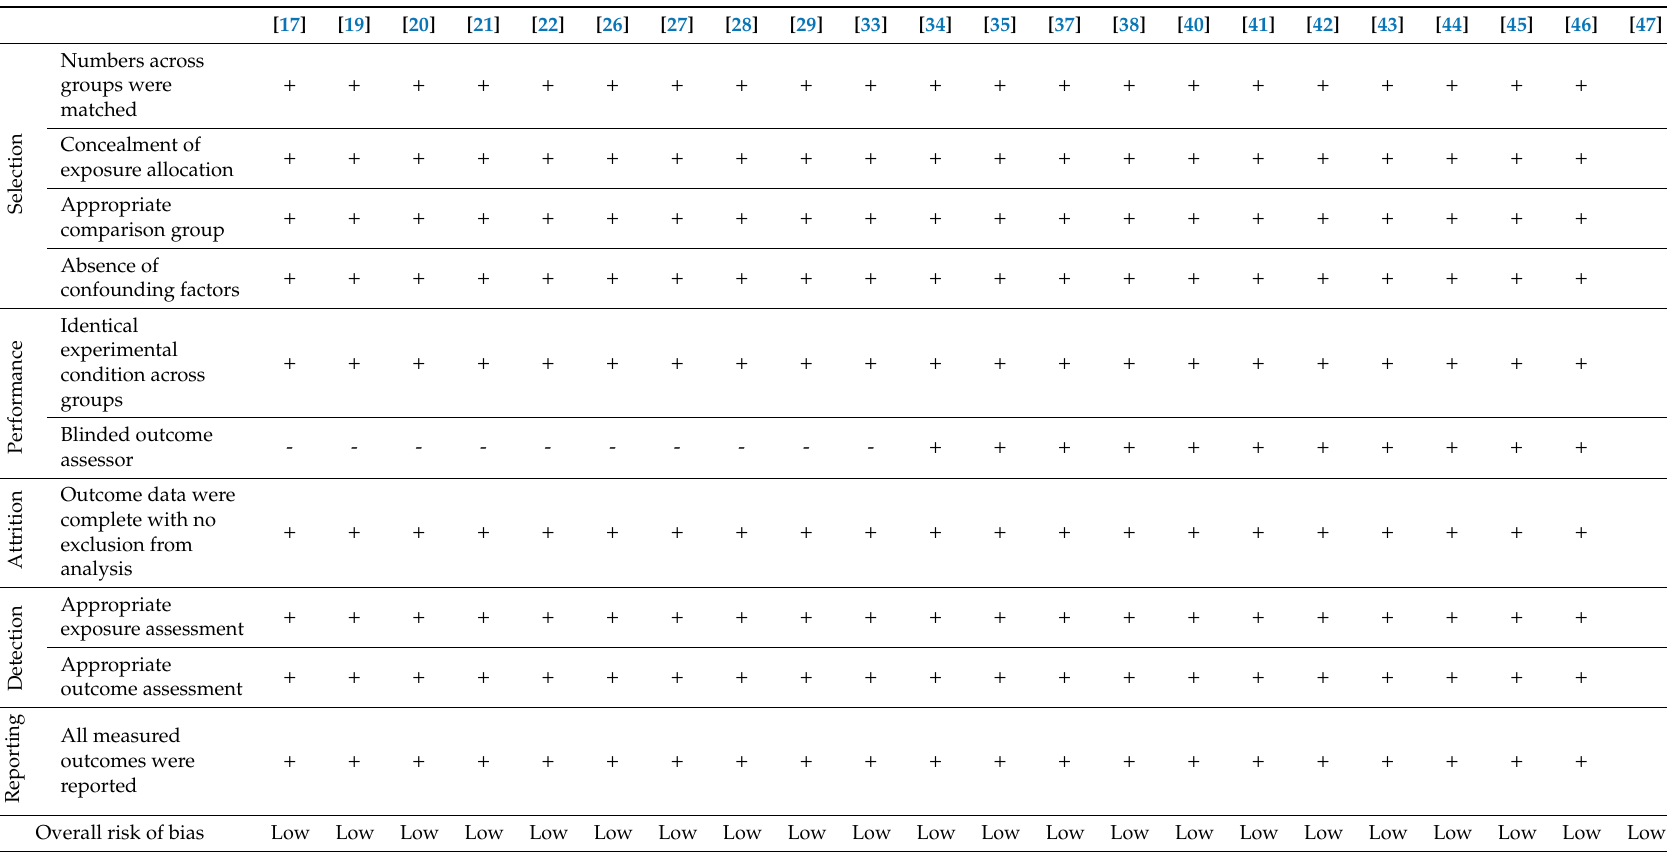
Table 3. Risk of bias assessment for pre-clinical reports on cardioprotective e ff ect of